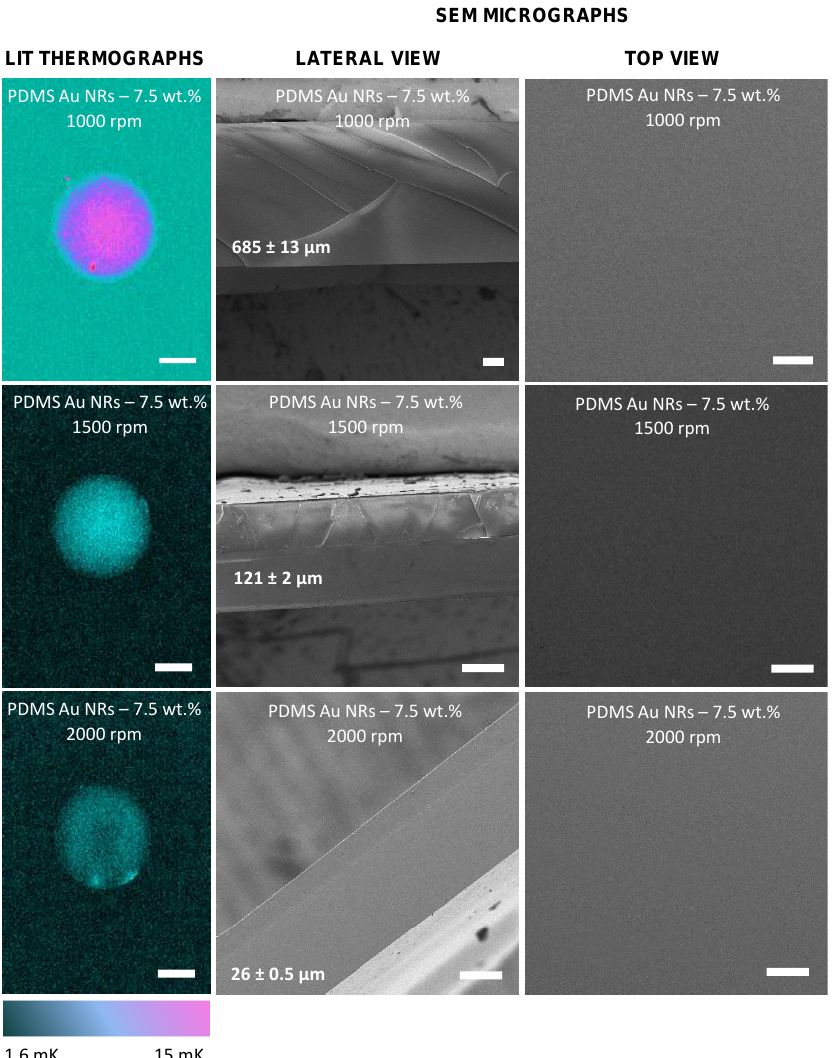
Figure A3. LIT thermographs (left column, scale bar: 5 mm) and SEM micrographs (middle and right columns, scale bar: 100 µm) showing the influence of the spinning speed on heat dissipation and film thickness. Films were irradiated using a light-emitting diode (LED) source centred at 525 nm for 1 min.